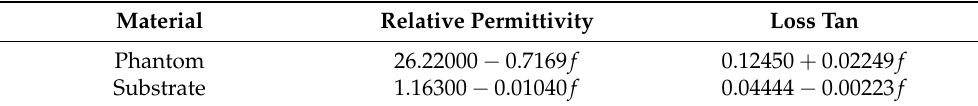
Figure 9. Tissue phantom : ( a ) fabricated antenna on the phantom; ( b ) phantom dimensions; ( c ) loss tangent and, ( d ) dielectric constant measurement of the fabricated antenna using the dielectric probe. Table 4. Phantom and substrate material properties curves fitted to the measured values; “ f ” is the frequency in GHz.